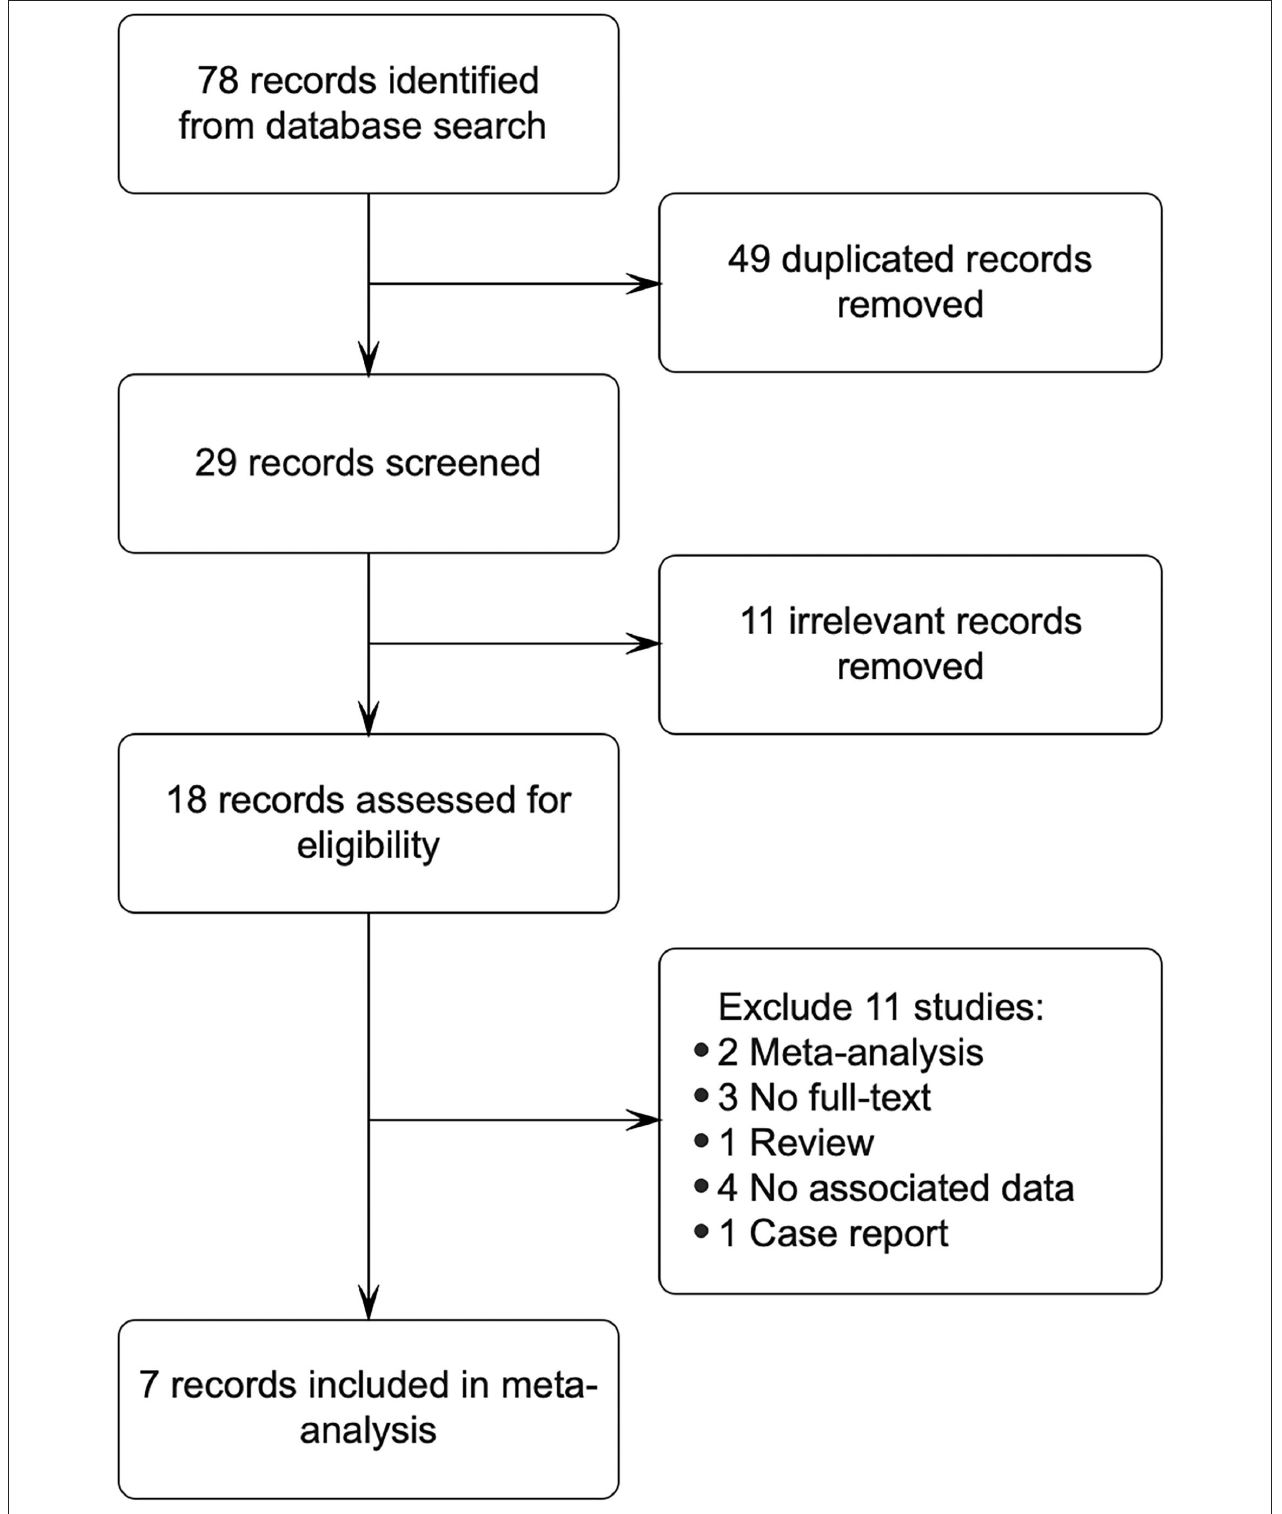
FIGURE 1 | The flow gram of the study was shown.